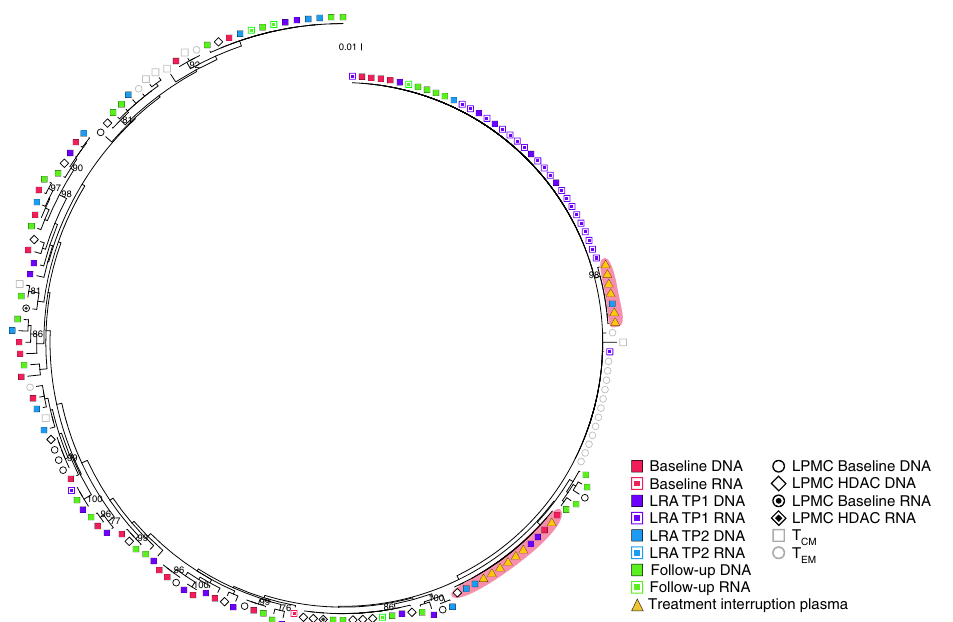
Figure 2 | Proviruses in CD4 þ T cells contribute to plasma viraemia during an analytical treatment interruption. Representative phylogenetic tree of HIV-1 sequences (from participant 17) showing that two clusters of identical HIV-1 sequences were detected in the plasma collected during the ATI that are identical to clonal expansions of cell-associated DNA sequences collected during panobinostat administration (red background). The plasma samples were collected 10 and 14 days following the analytical treatment interruption. Peripheral blood samples were collected at baseline, 1 day after the first dose of panobinostat (TP1), 18 days after the first dose of panobinostat (TP2) and 38 days after the final panobinostat dose. Intestinal lamina propria mononuclear cells were collected at baseline (1 week before the first panobinostat dose) and during week 4 of the panobinostat trial. Cell subsets were sorted from peripheral blood samples collected 38 days after the final panobinostat